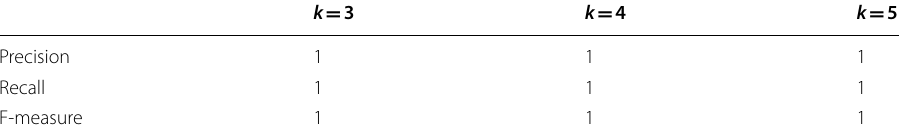
Table 18 Performance of Jaccard coefficient in detecting near-duplicate documents (R8_ NDD) k 3 k 4 k 5 = = = Precision 0.641 0.8065 0.8929 Recall 1 1 1 F-measure 0.7813 0.8928